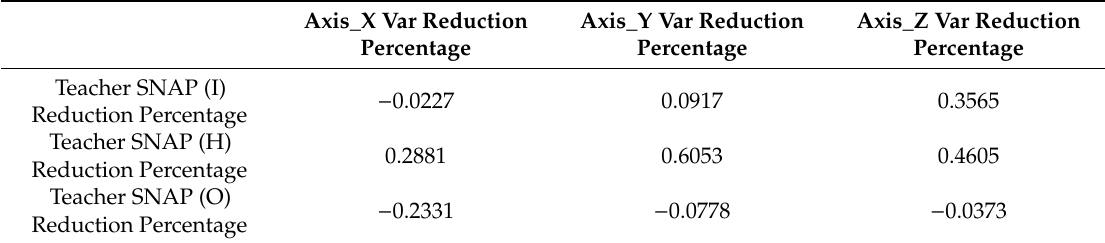
Table 3. Correlation coefficient between reductions of SNAP subscales and variance values across three axes.